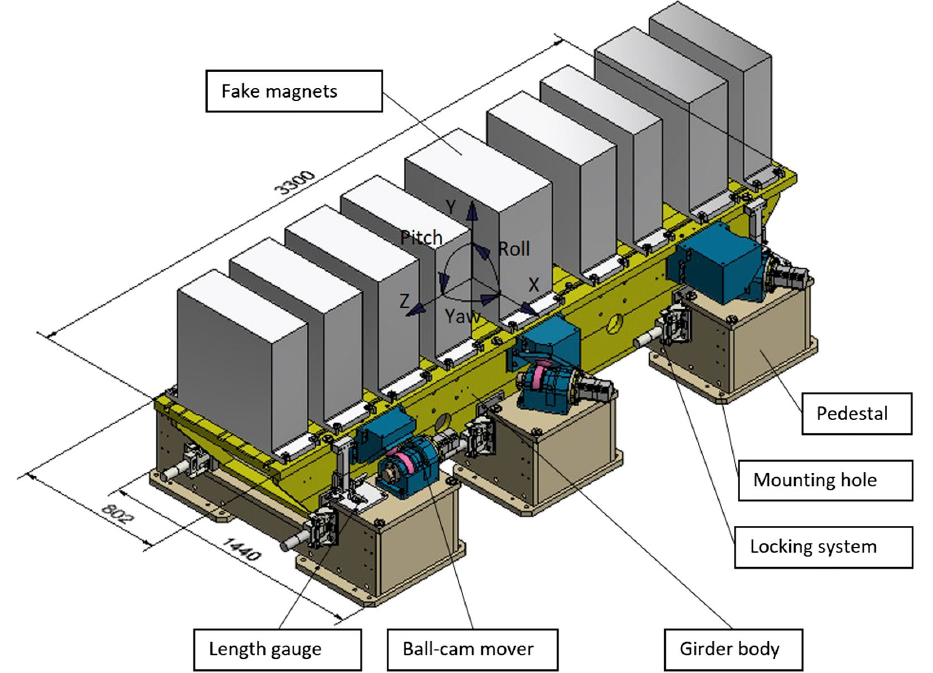
FIG. 1. Design sketch of the autotuning magnet-girder prototype.